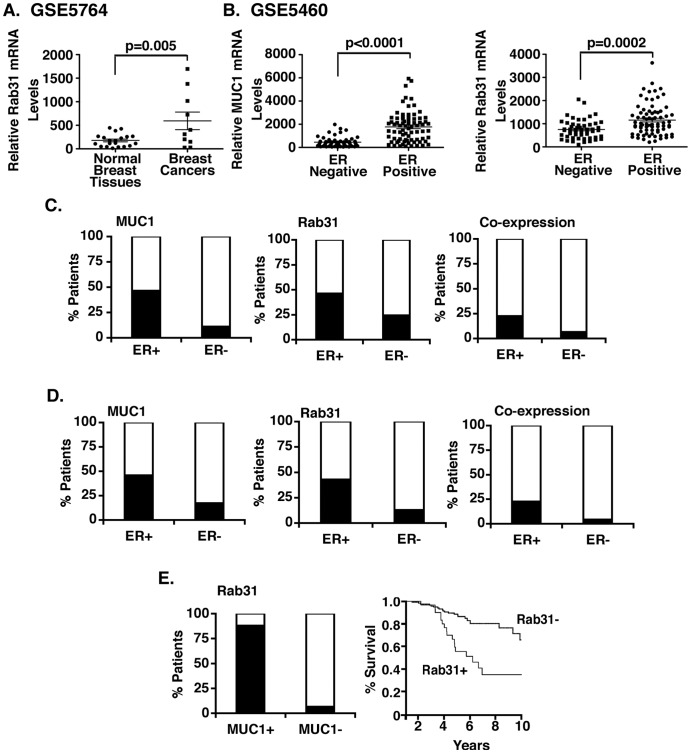
Expression of Rab31 in human breast cancers.A. Analysis of Rab31 mRNA levels in the GSE5764 dataset from 23 normal breast tissues and 10 breast tumors. The results are expressed as the relative Rab31 mRNA levels based on the normalization values in the dataset. B. Analysis of MUC1 mRNA (left) and Rab31 mRNA (right) levels in the GSE5460 dataset from 76 ER+ and 53 ER− breast tumors. Normalized microarray data were separated into ER+ and ER- groups. C and D. Analysis of MUC1 mRNA (left), Rab31 mRNA (middle) and co-expression levels (right) in the Loi dataset (C, 262 ER+ and 45 ER− breast tumors) and van de Vijver dataset (D, 226 ER+ and 69 ER− breast tumors). E. Analysis of Rab31 and MUC1 mRNA co-expression levels in 147 ER+ breast tumors (left). Percentage overall survival for patients with Rab31-positive versus Rab31-negative breast tumors (right; Chanrion dataset).